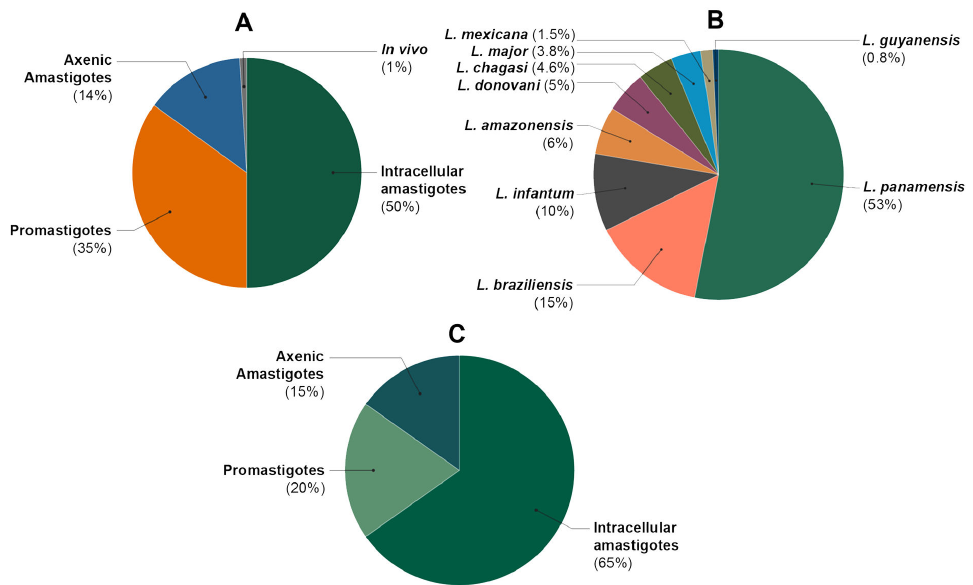
Figure 4. Characteristics of antileishmanial assays reported in those papers included in the present review. ( A ) Distribution of antileishmanial in vitro (subdivided into parasite forms, i.e., intracellular amastigotes, promastigotes and axenic amastigotes) and in vivo assays. ( B ) Distribution of Leishmania species involved in the antileishmanial in vitro assays. ( C ) Distribution of parasite forms used in antileishmanial in vitro assays against L.